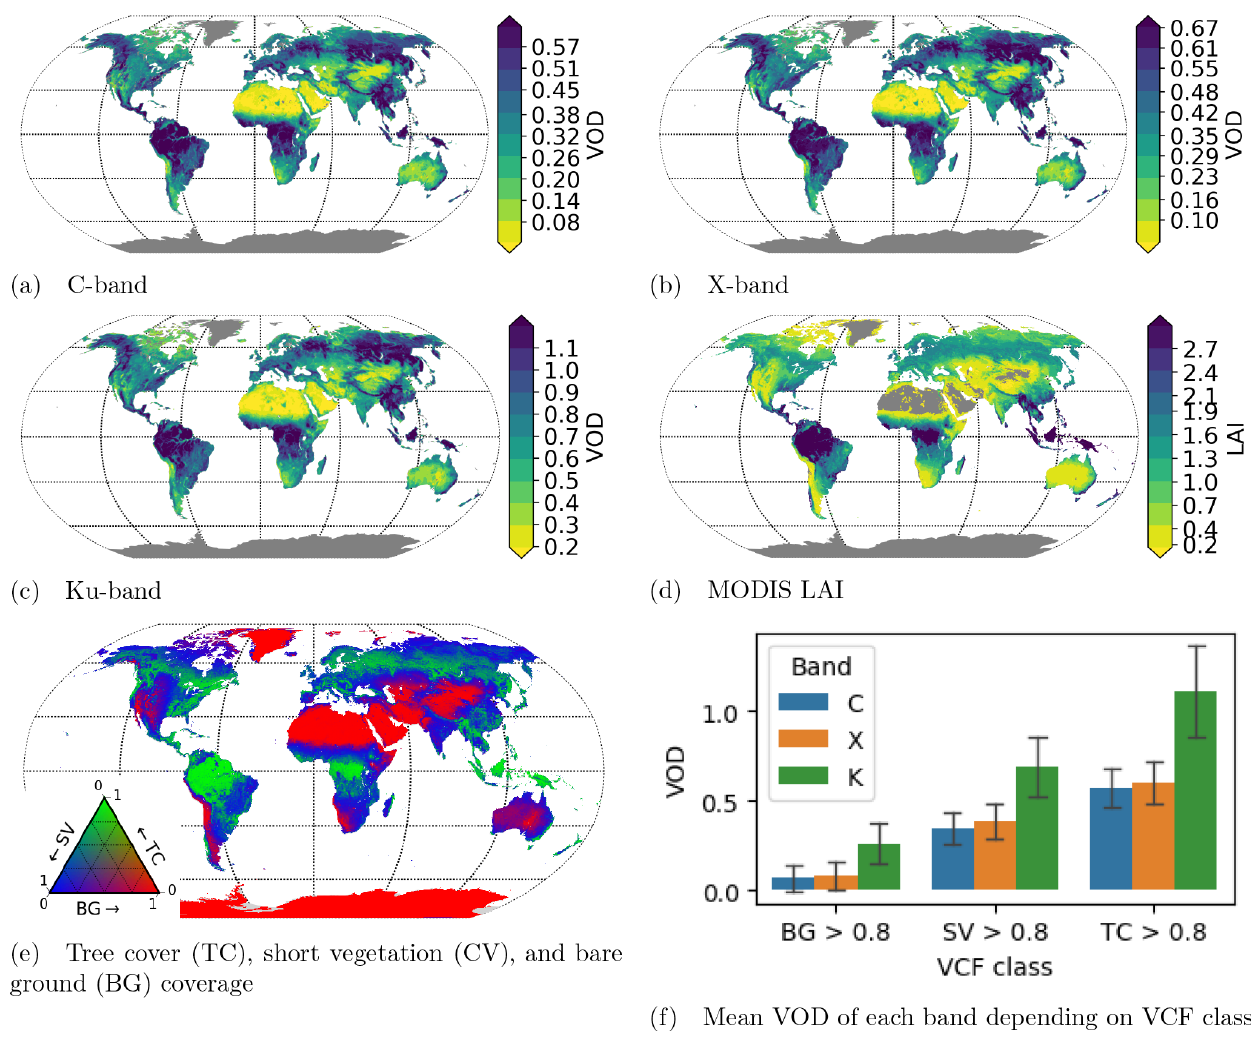
Figure 4. Global spatial patterns of average multi-sensor VOD from each band (2002–2017), average MODIS LAI (2002–2017), and average VCF (2002–2016) and distribution of VOD for locations with high tree cover (TC), short vegetation (SV), and bare ground (BG) greater than 0.8. The error bars indicate the standard deviation within each